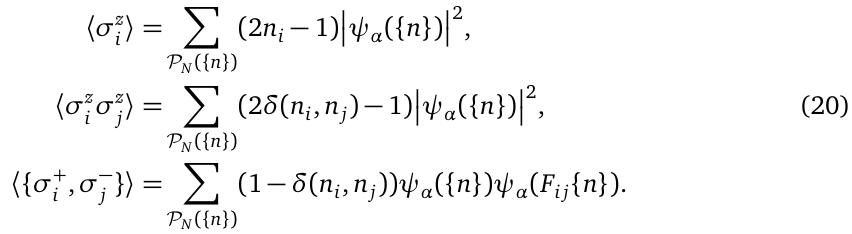
= 4.3 ( 1 ) while ν = 2.1 ( 2 ) , β = − 0.15 ( 3 ) c